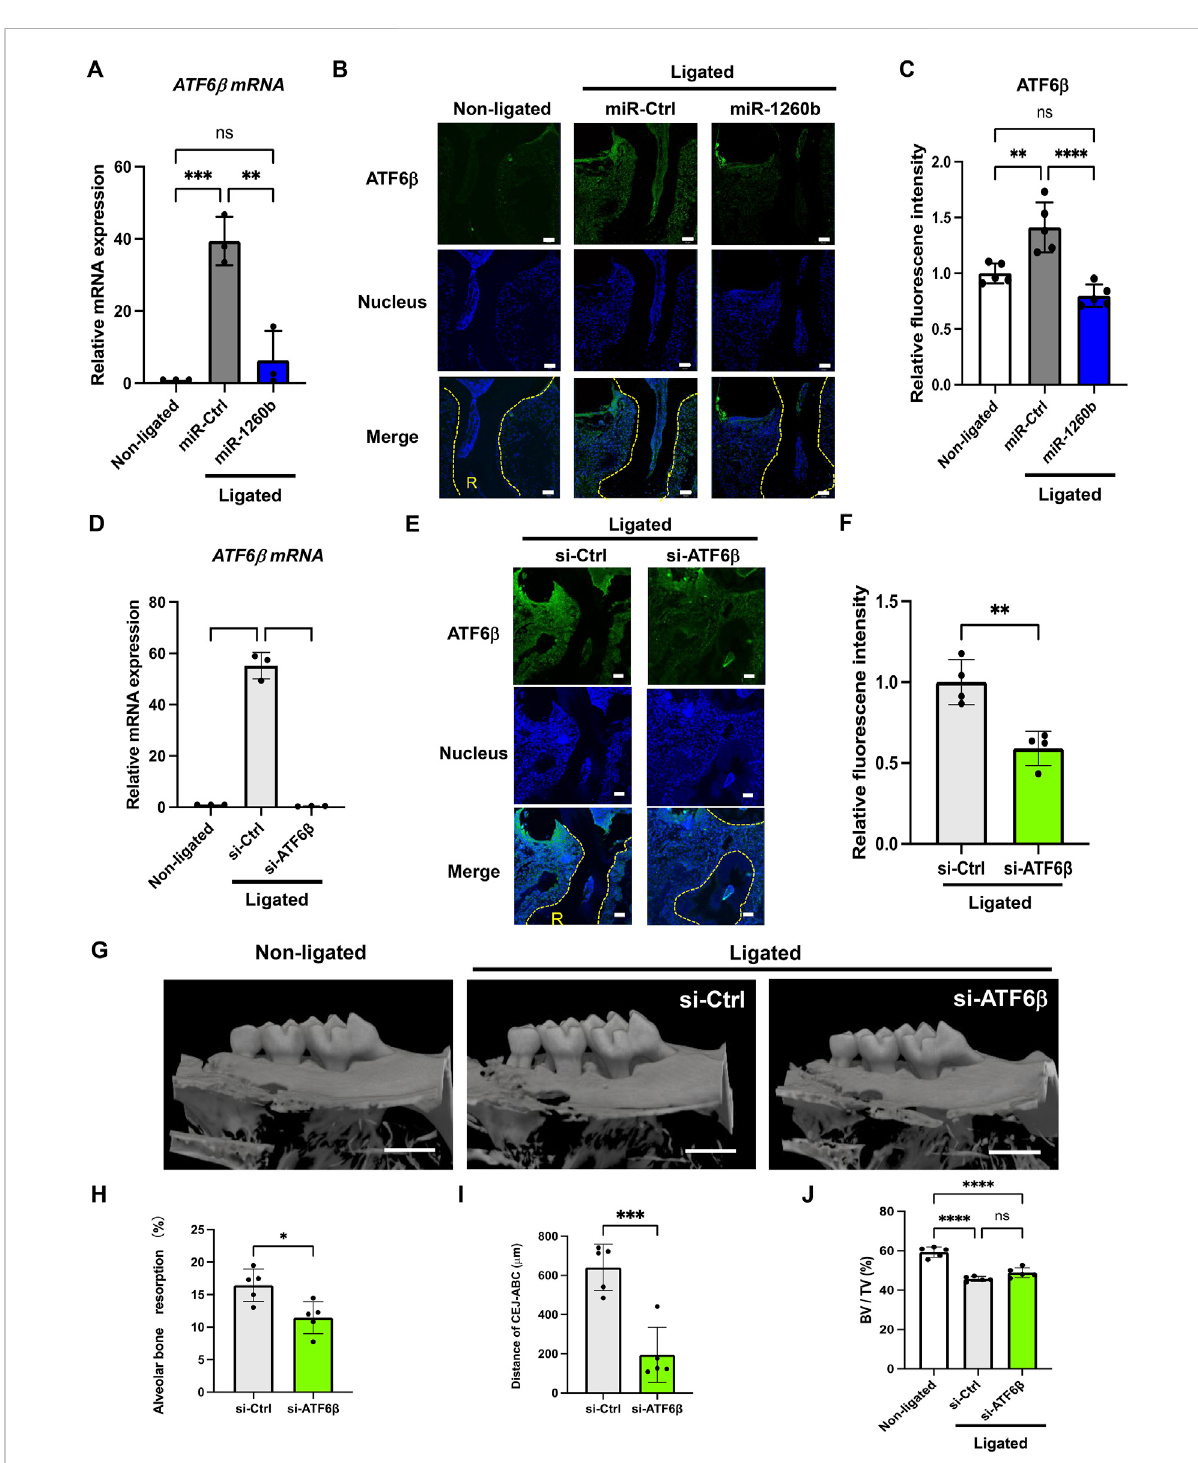
miR-1260b-mediated down-regulation of ATF6 β is essential for the inhibition of periodontal bone loss. Effects of miRNA injection on the expression of ATF6 β in the mice periodontal model on day 1 (A) and day 7 (B,C) after ligation. (A) ATF6 β mRNA expression in mouse gingival tissue ( n = 3). (B) Immuno fl uorescence staining of ATF6 β (green) in the mouse periodontal tissue. Nuclei were stained with DAPI (blue). R, root. Scale bar = 50 μ m. (C) Intensity of ATF6 β fl uorescence in each sample was measured in each group ( n = 5). (D – F) Validation of ATF6 β knockdown in mice periodontal model on day 1 (D) and day 7 (E,F) after ligation. (D) ATF6 β mRNA expression in mouse gingival tissue ( n = 3). (E) Immuno fl uorescence staining of ATF6 β (green) in the mouse periodontal tissue. Nuclei were stained with DAPI (blue). R, root. Scale bar = 50 μ m. (F) Intensity of ATF6